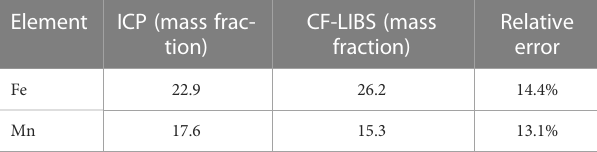
TABLE 2 The relative measurement error analysis of ICP and CF-LIBS measurement results and.